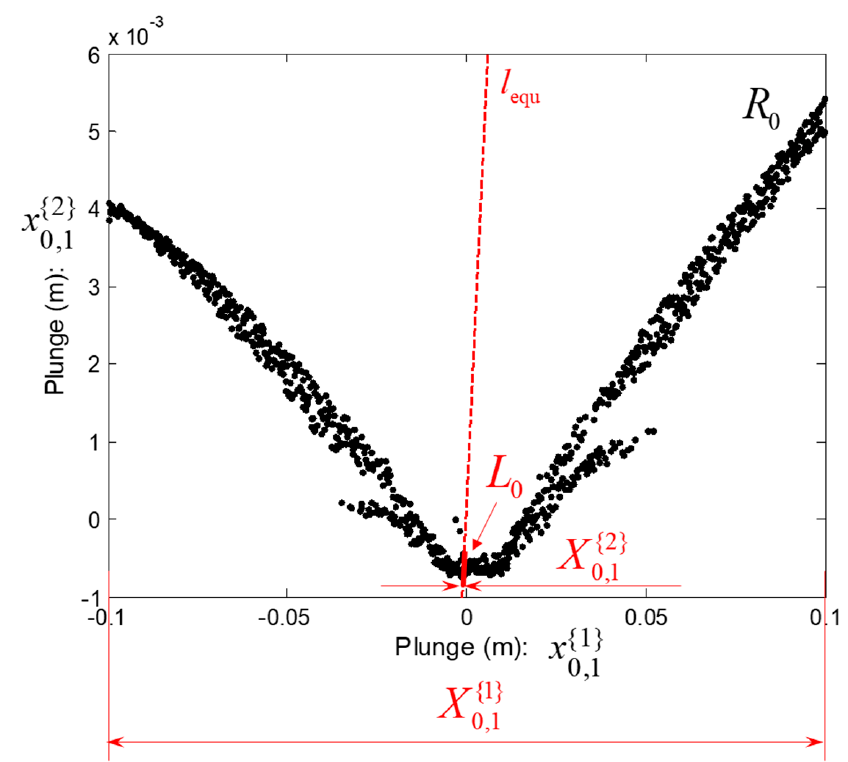
{ n } { n + 1 } (cid:2777),(cid:2192){(cid:2196)} (cid:2777),(cid:2192){(cid:2196)(cid:2878)(cid:2778)} being contracted to (cid:2180) by means of the spatial pat- being contracted to X by means of the spatial pattern. 0, j 0, j